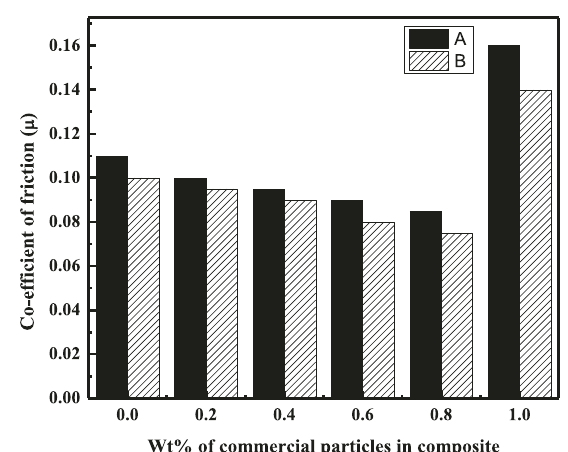
Fig. 10 Coef fi cient of friction of WC vs. Wt% concentration of the fi ller in the composite conducted at 2 N applied load and 300 m sliding distance at room temperature in A dry and B wet conditions